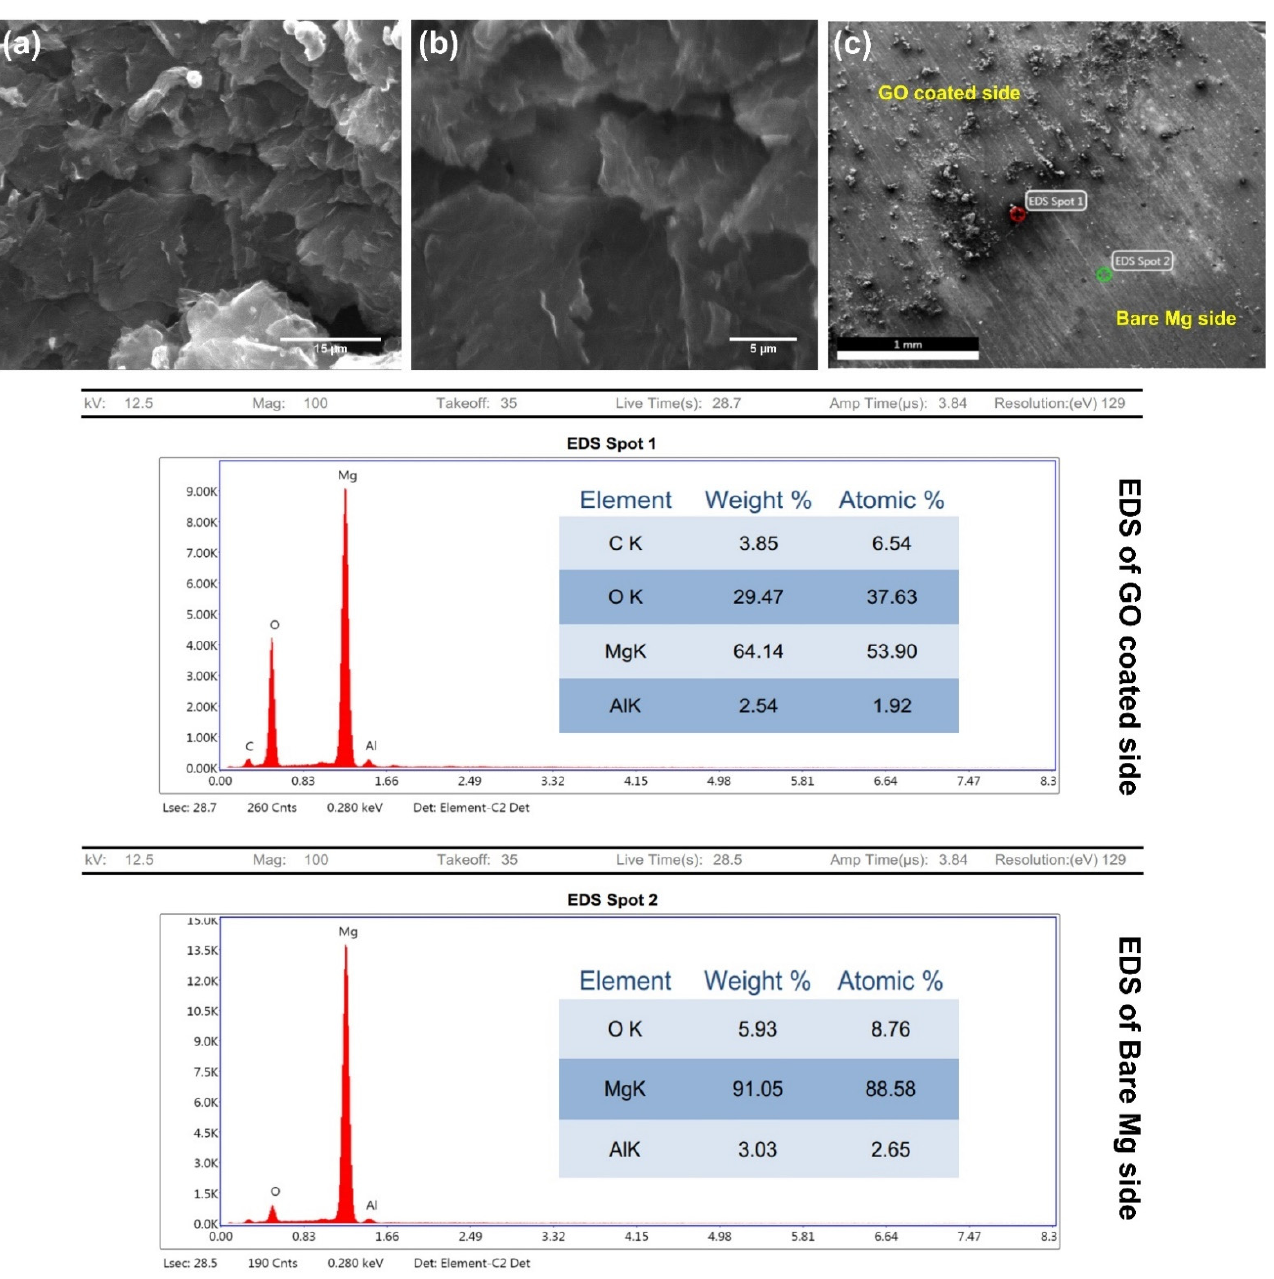
Figure 5. SEM images of ( a , b ) GO sheets and ( c ) EDX spectrum of uncoated Mg and EPD-GO-E- coated area. coated